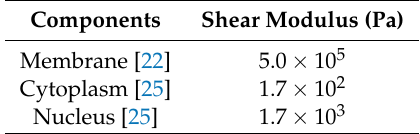
Table 4. Estimated shear modulus of the hyperelastic